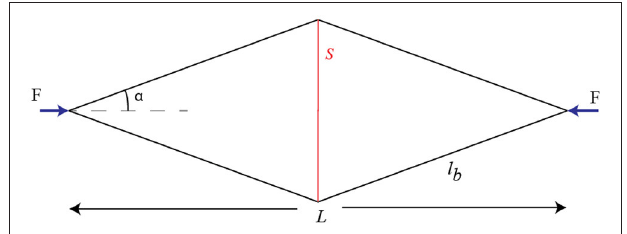
FIGURE 1 | Configuration of the planar D-bar (Complexity q